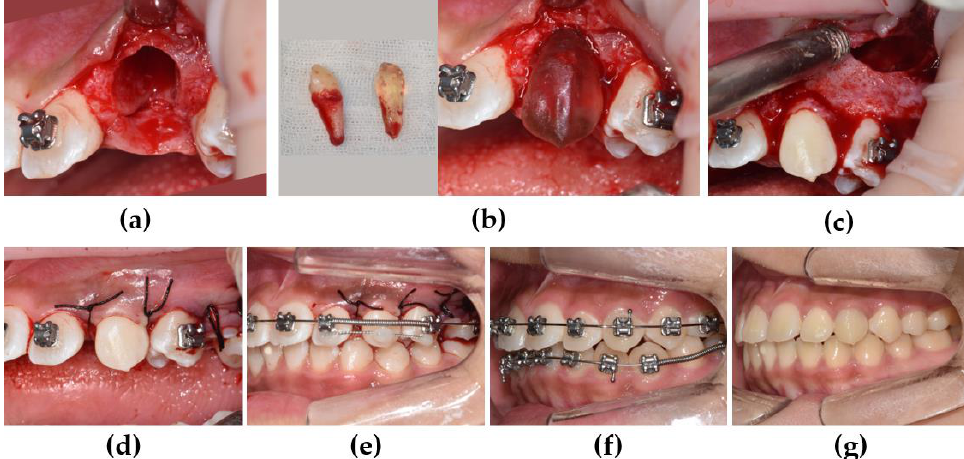
Figure 7. Autotransplantation of impacted left maxillary canine (Case 2): Surgical procedure ( a – e ). The shape and size of the 3D-printed replica is similar to those of the real extracted canine. The clinical condition at the 6-month ( f ) and 1-year follow-up ( g ) is shown.